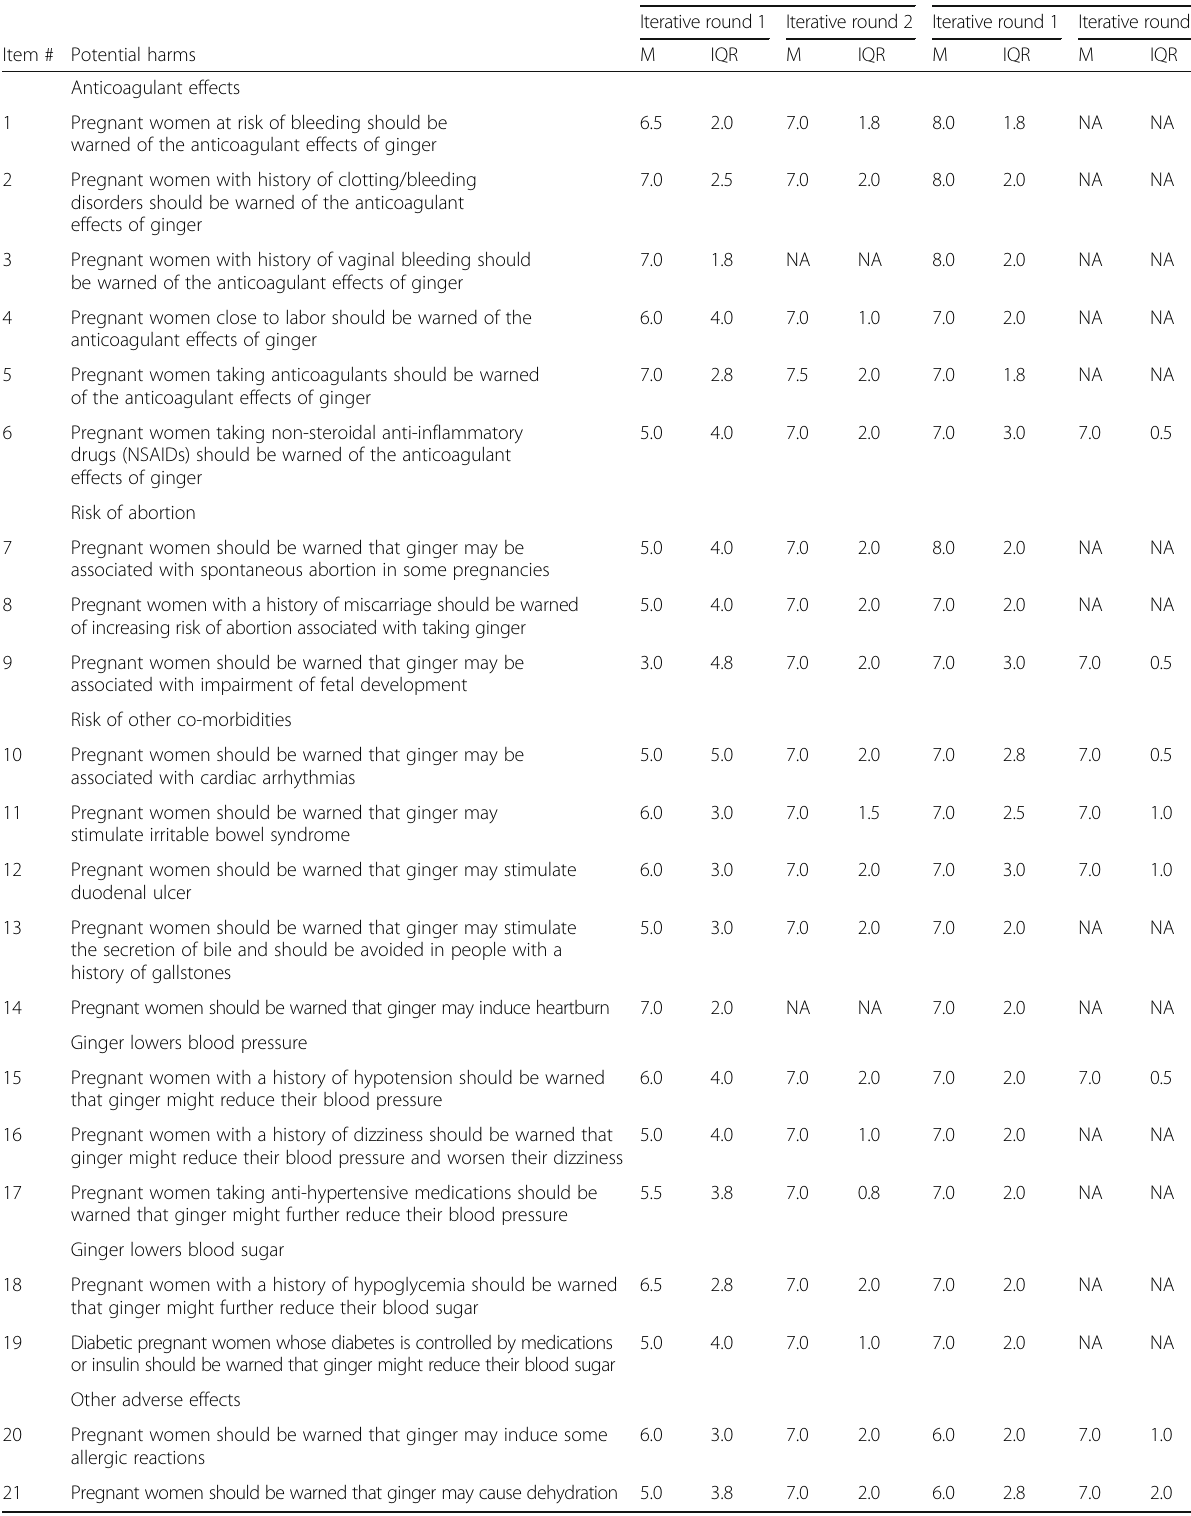
Table 3 Important potential harms of using ginger for the management of NVP to be addressed during the clinical